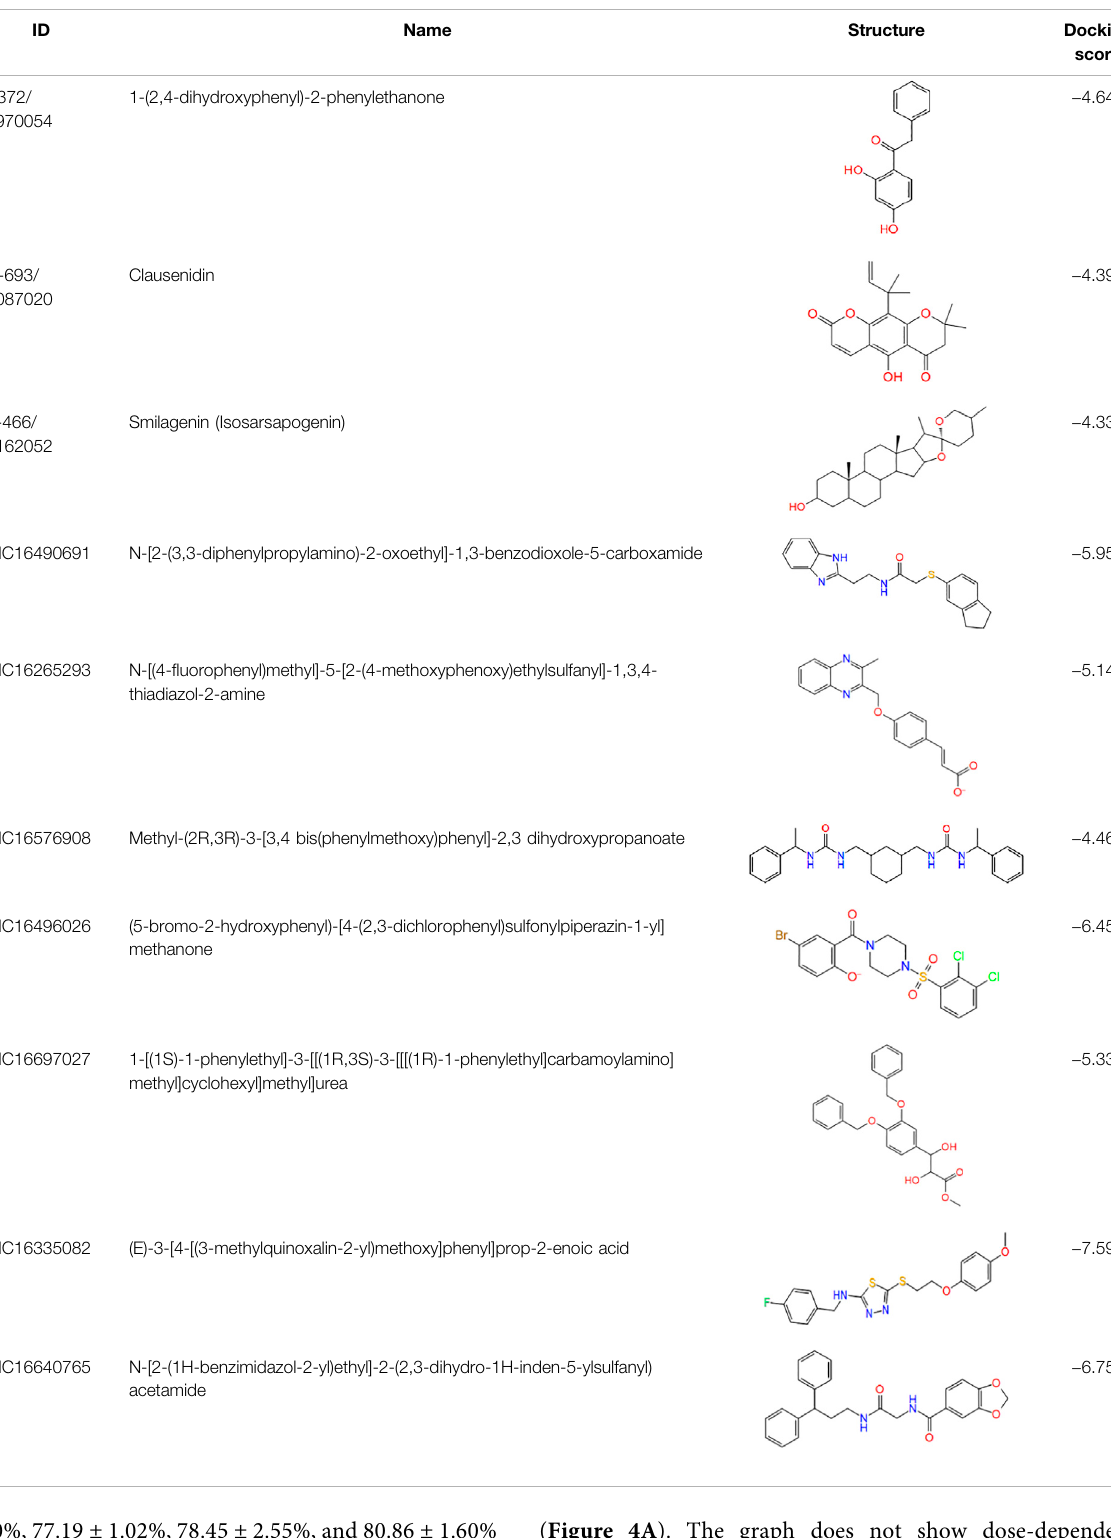
( Figure 4A ). The graph does not show dose-dependence probably because hypoxic conditions increase the expression of hypoxia-inducible factor-1 (HIF-1). Under hypoxic